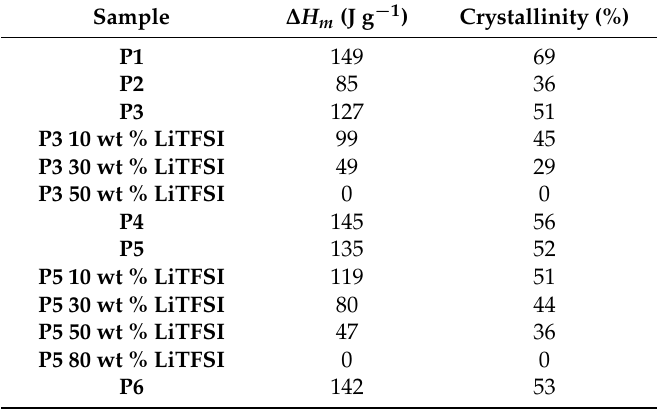
Table 1. ∆ H m and degree of crystallinity of SPE-P3 and SPE-P5 with different amounts of LiTFSI. Sample